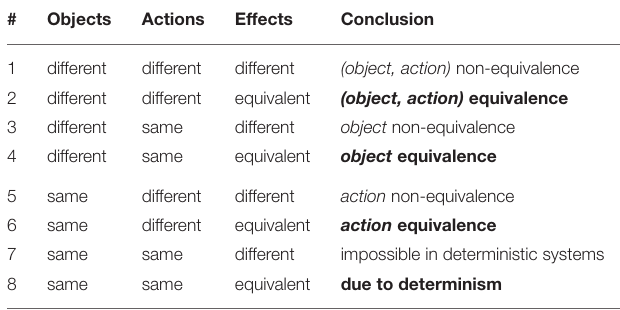
TABLE 2 | Comparison of two affordances, when actions are described with respect to